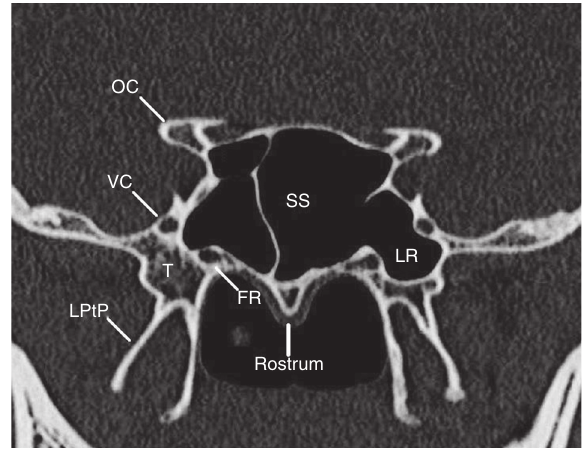
The coronal section at which both the vidian canal and foramen rotundum are visualized (usually at the midpoint of sphenoid sinus). SS, sphenoid sinus; FR, foramen rotundum; VC, vidian canal; LPtP, lateral pterygoid plate; OC, optic canal; LR, lateral recess.